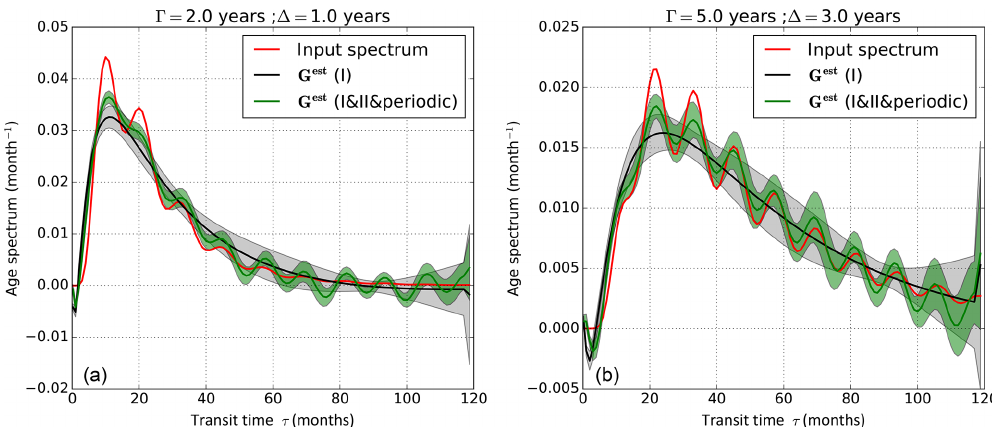
Figure 10. Input age spectra (red), defined using Eq. (33) with A = 0 . 3, φ = π (for left and right panels), (cid:48) = 2 years and (cid:49) = 1 year (a) 2 and (cid:48) = 5 years, (cid:49) = 3 years (b) . Retrieved age spectra using (black) parent decaying tracers only or (green) daughter and parent tracers and two sets of periodic tracers with periods of 1 and 2 years. The full lines are average retrieved age spectra over 100 retrievals from 100 sets of pseudo-tracer observations. The gray and green shadings correspond to ± the standard deviation of the 100 retrievals and show the dispersion-noise-induced